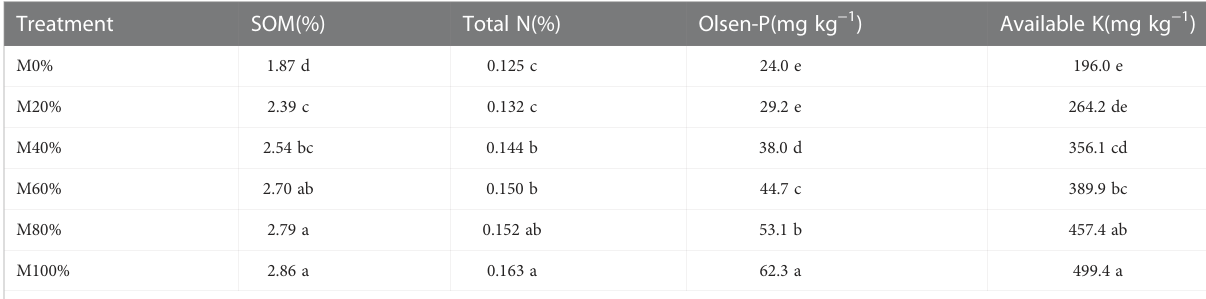
TABLE 2 Soil organic matter (SOM), total N, Olsen-P and available K at harvest in 2020 for different organic substitution ratios of N fertilizer. Treatment